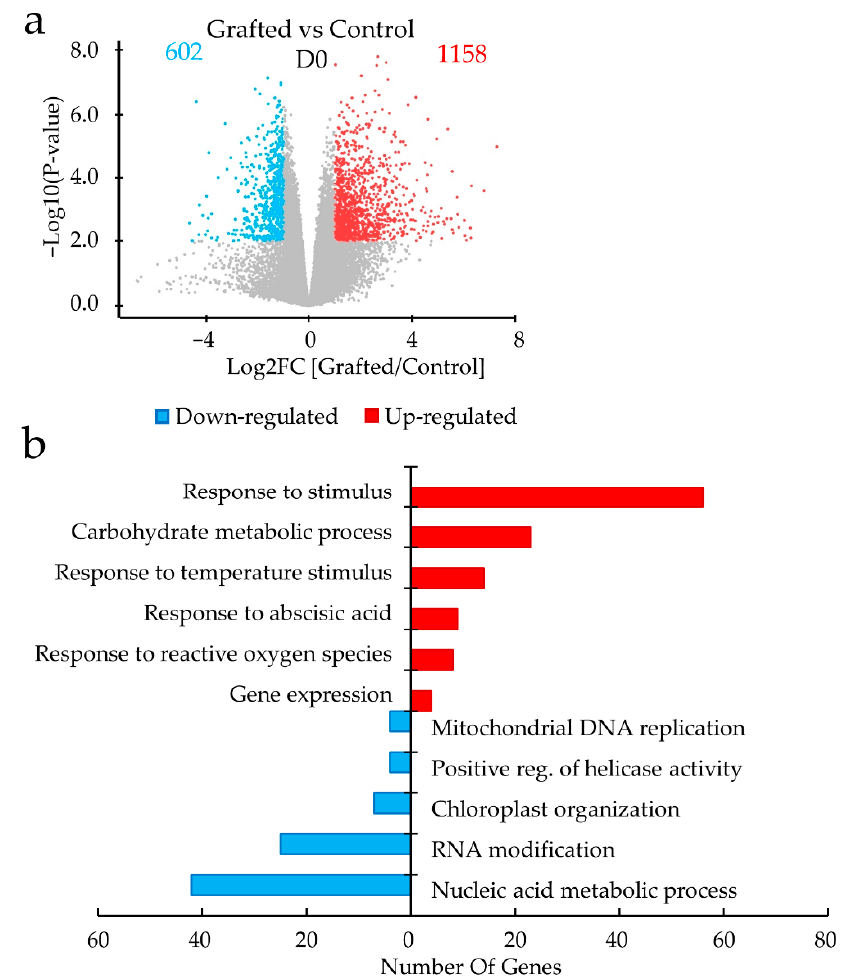
Figure 3. Comparison of the differentially expressed genes (DEGs) in grafted and control before drought stress treatment. ( a ) Volcano plot representation of DEGs up-regulated and down-regulated by grafting. The x axis shows Log 2 fold change (FC) between Grafting vs. Control and y axis shows − Log10 ( p -value). ( b ) Bar plot showing gene ontology (GO) enrichment analysis (Panther, false discovery rate < 0.05) for biological process in DEGs by grafted plants. Red and blue color indicate high and low gene expressions on significant DEGs (Adj. p < 0.05, Log 2 FC ≥ |1|). The x axis shows the number of genes categorized in each GO term ( y axis). Table 1. List of hormone-related genes differentially expressed by grafting before drought stress (D0). Gene ID